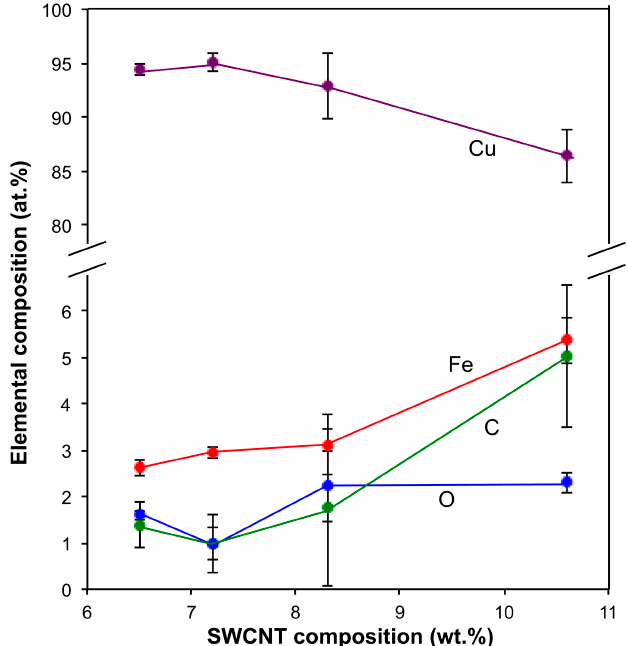
Figure 4. Elemental composition as a function of added SWCNT content (error bars in standard error of mean, n = 3).